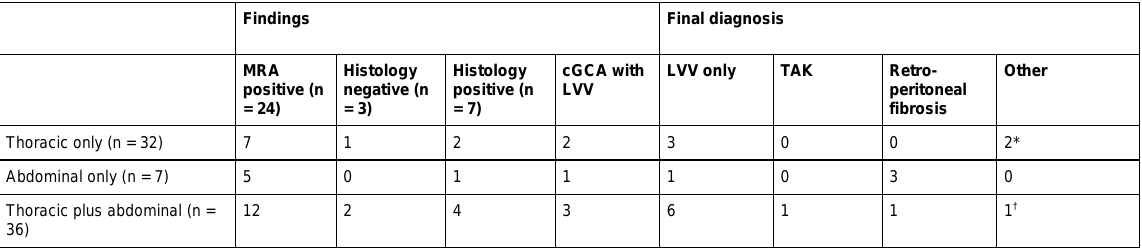
Table 3: Final diagnosis in patients with positive MRA. cGCA = cranial giant-cell arteritis; LVV = large-vessel vasculitis; MRA = magnetic reso- nance angiography; TAK = Takayasu